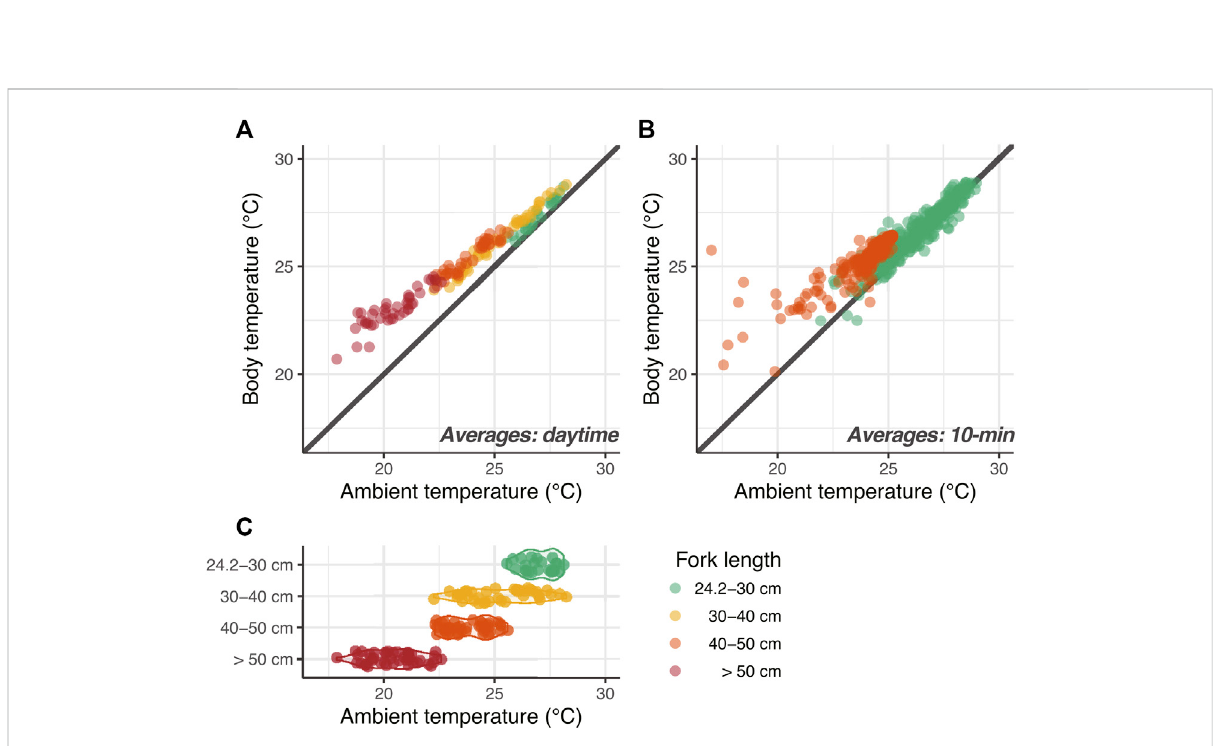
FIGURE 3 Thermal pro fi les of juvenile PBT. (A) Relationship between daytime mean ambient and body temperatures. Color indicates body size class. (B) Daytime mean ambient and body temperatures at 10 min intervals at 24 cm FL (green) and 45 cm FL (orange). (C) Daytime mean ambient temperature in each size